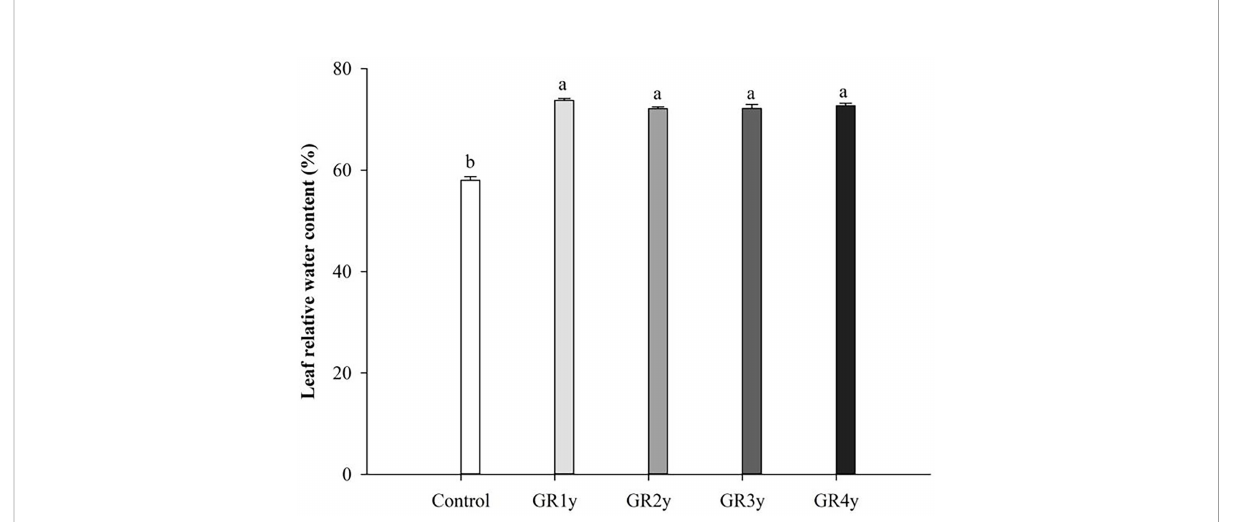
FIGURE 6 Effect of grazing rest during the spring regreening period on the leaf water content of the degraded alpine meadow vegetation. Bars represent SEs. Common letters above columns indicate no signi fi cant difference at P = .05. GR 1y, GR 2y, GR 3y, and GR 4y mean grazing rest for 1, 2, 3, and 4 years, respectively.